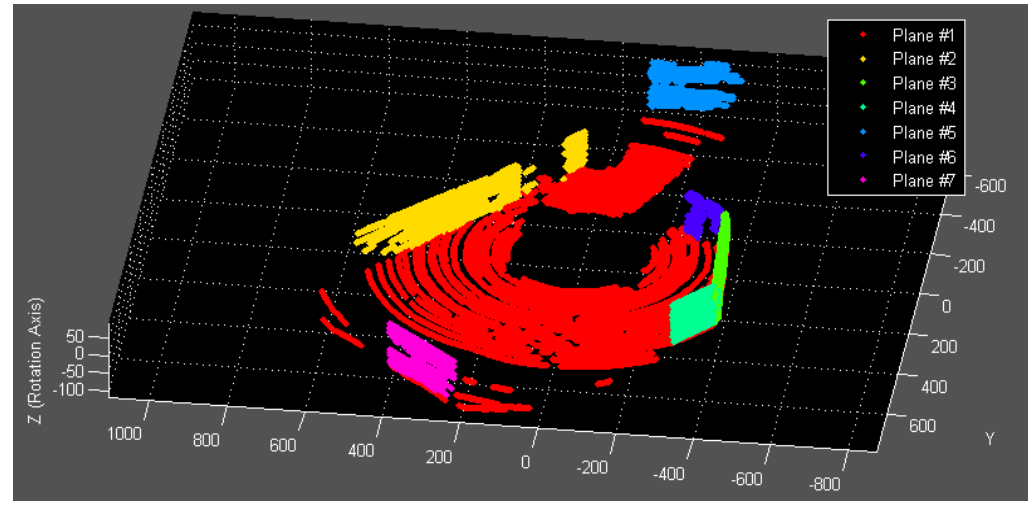
Figure 6. Established calibration data containing seven planar